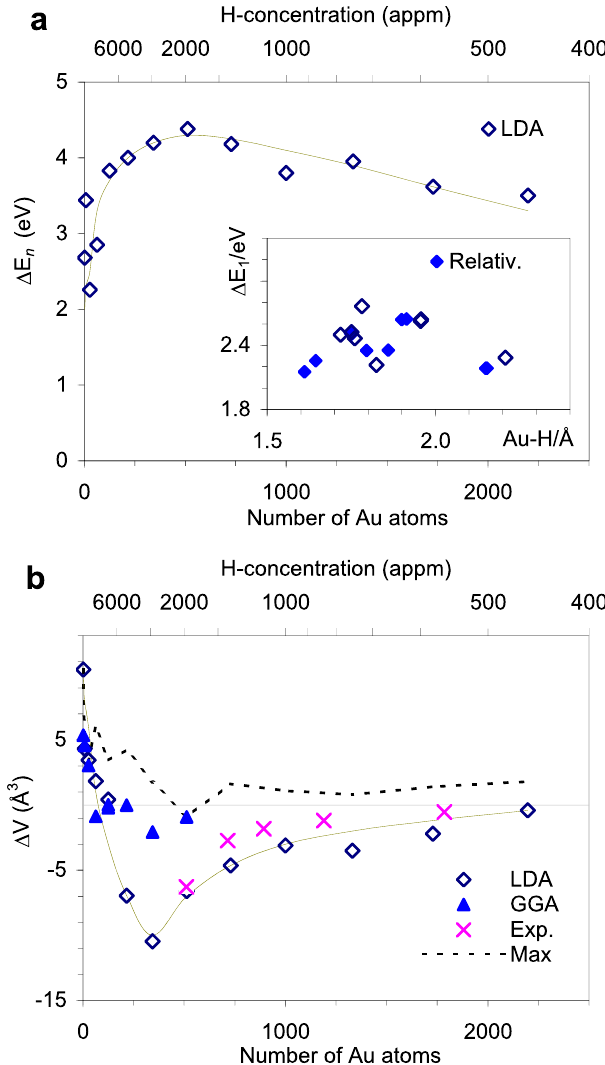
Fig. 4 Results of the structure optimization of large supercells. a The LDA cohesive energy as a function of the hydrogen concentration (supercell size). The inset compares Δ E 1 obtained with and without a relativity correction for the case of mono gold hydride AuH. b The LDA derived maximum positive and negative changes of the unit cell volume as the hydrogen concentration (supercell size) changes. The data obtained by GGA/PBE are also shown, but other data are omitted for